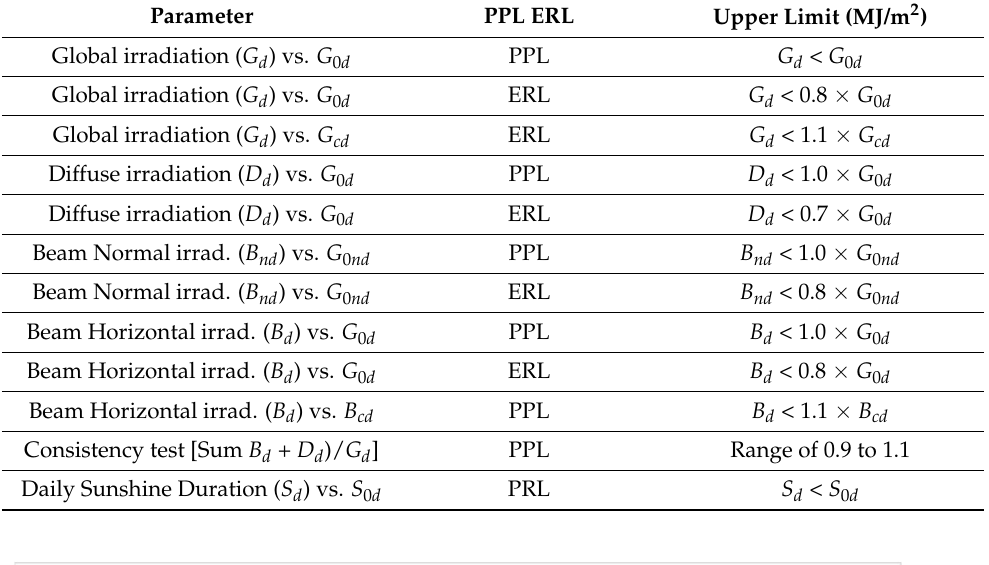
Table 4. Daily Upper limits of Physically Possible tests (PPL) and Extremely Rare tests (ERL) (Lower limit of G d is 0.03 × G 0 d ) [5].